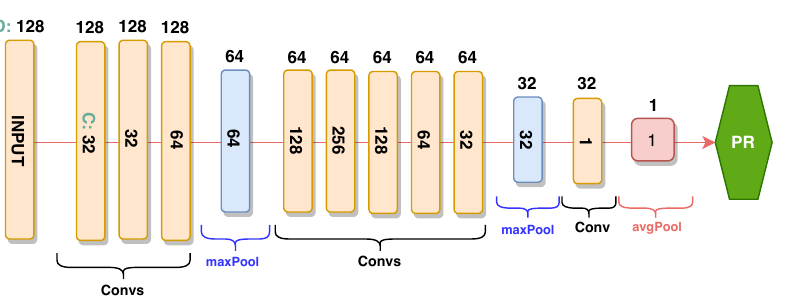
Figure 4. Illustration of the effect of RateEstNet on the input. The temporal resolution (D) marked at the top and the number of channels (C) in the middle.